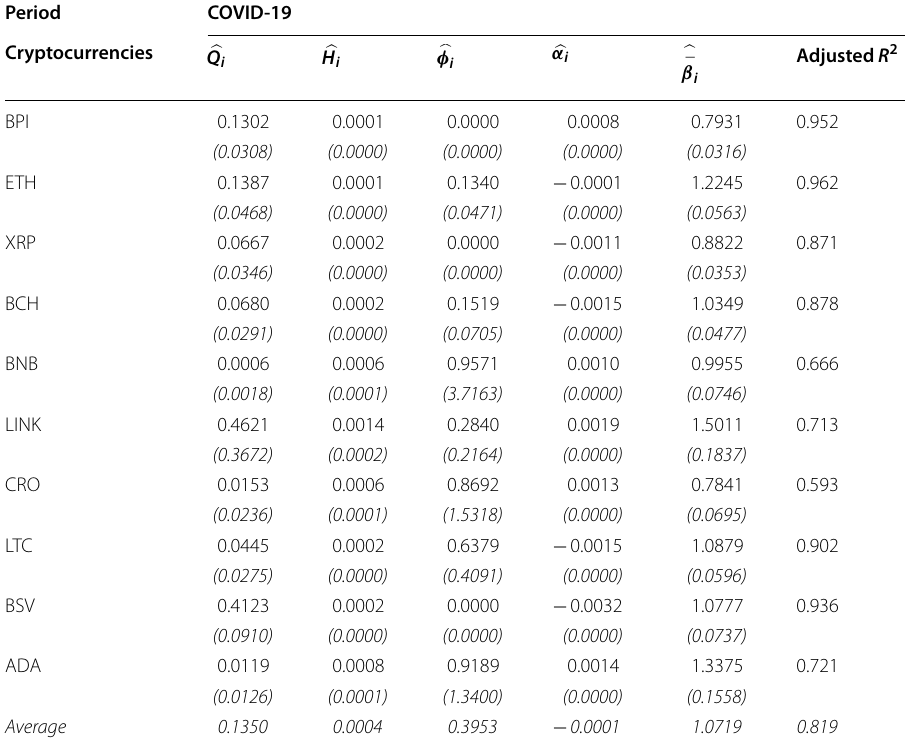
Table 9 Tv-LMM via KFMR parameter estimates (with standard errors ) of cryptocurrencies during the COVID-19